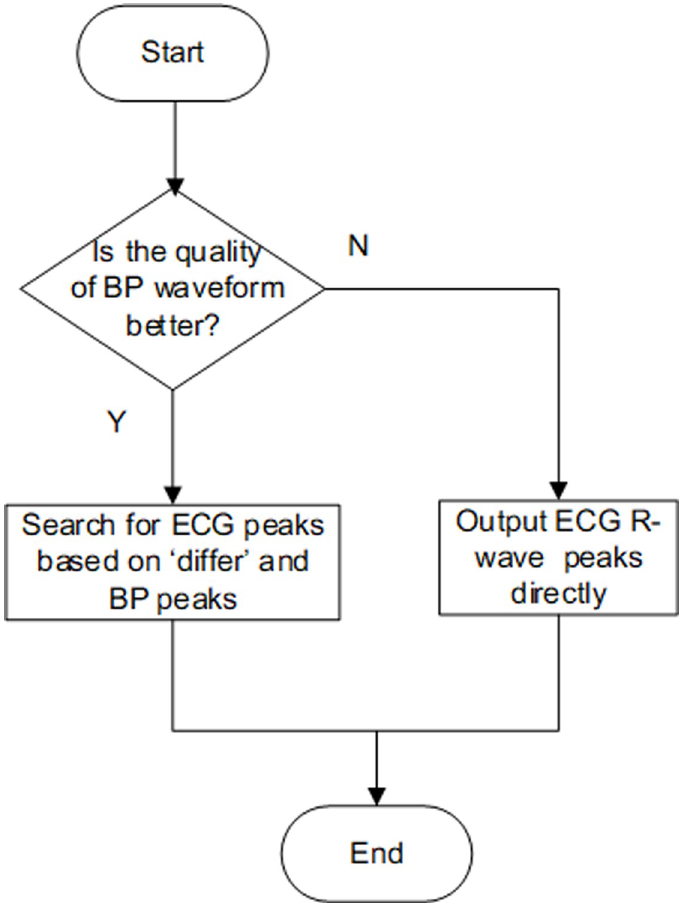
Fig 10. Flow diagram for